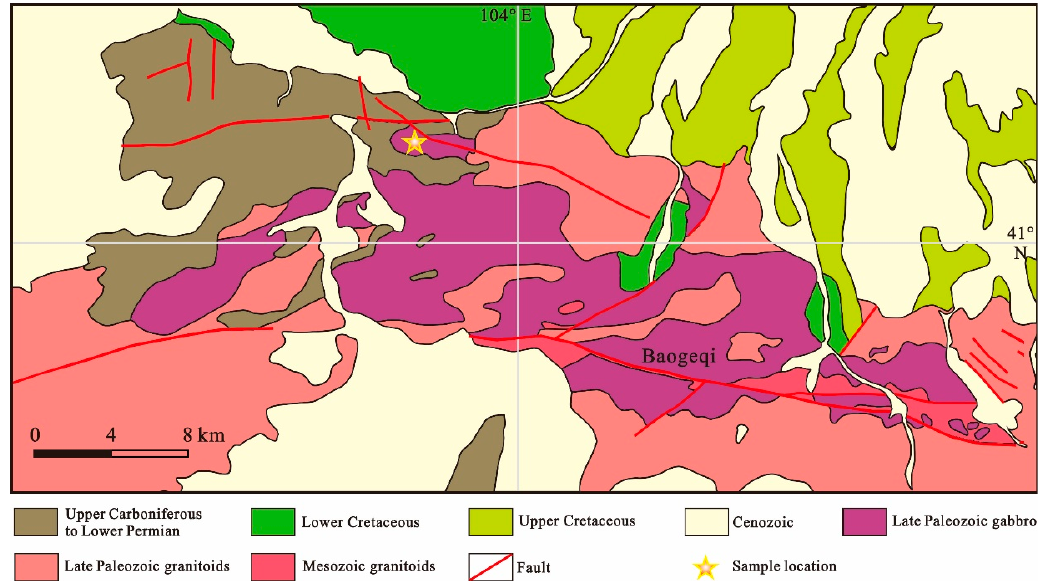
Figure 2. Geological map of the study area showing the distribution of the Baogeqi gabbro pluton.